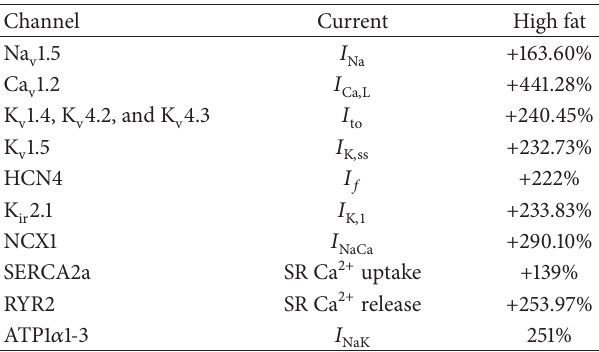
Table 2: Simulated changes in current density based on the mRNA expression differences shown in Figures